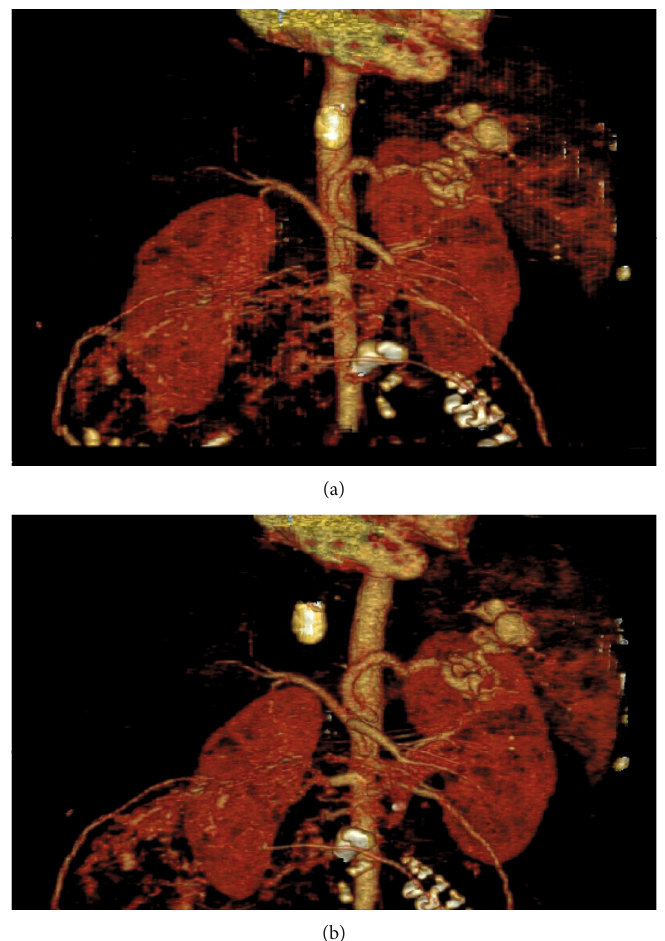
Figure 2: (a) CT angiogram 3-D reconstruction showing the tortuous splenic artery aneurysm (anterior view). (b) CT angiogram 3-D reconstruction showing the tortuous splenic artery aneurysm (posterior view).